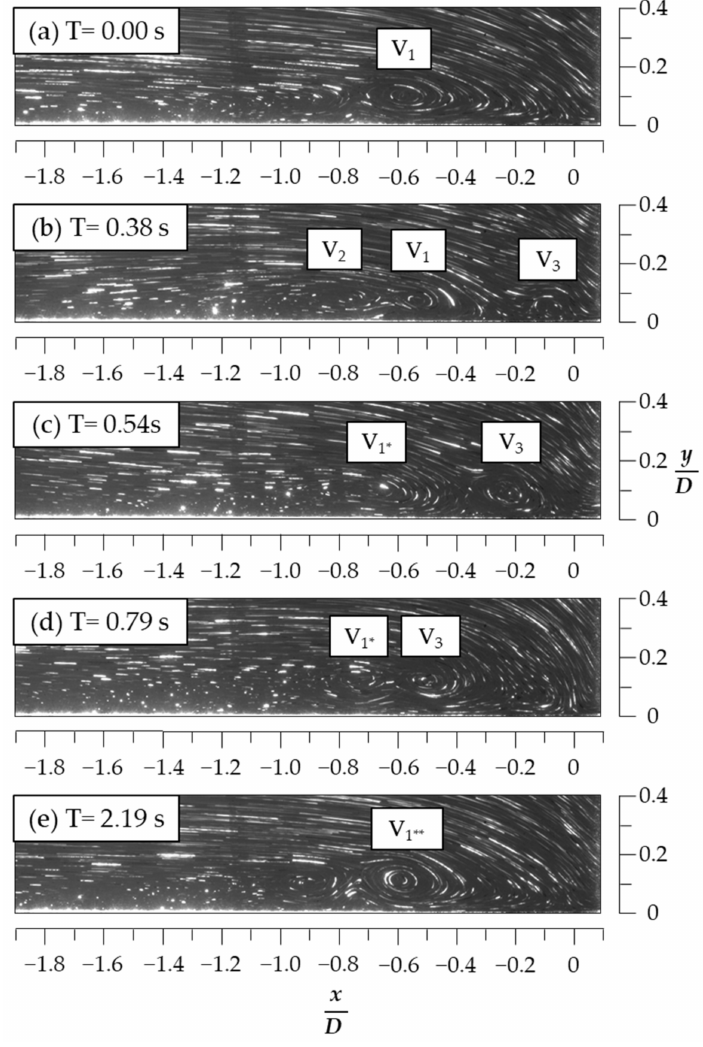
Figure 15. Time-series flow visualization of the HSV’s kinematic mode: “mixed” in the z = 0.4 cm plane when H / D = 1.5. ( a ) The core of the primary vortex V 1 was initially located at ( x / D , y / D ) = ( − 0.57, 0.10); ( b ) two new roll-up vortices V 2 and V 3 were formed after a bulk of “flow disturbances“ was moving into V 1 ‘s region; from ( b ) to ( c ), V 1 and V 2 were merging with each other to form a new primary vortex V 1* while the V 3 was moving upstream; from ( d ) to ( e ), V 1* and V 3 were merging with each other, and finally a new primary vortex V 1** was formed with its core located at ( x / D , y / D ) = ( − 0.59,